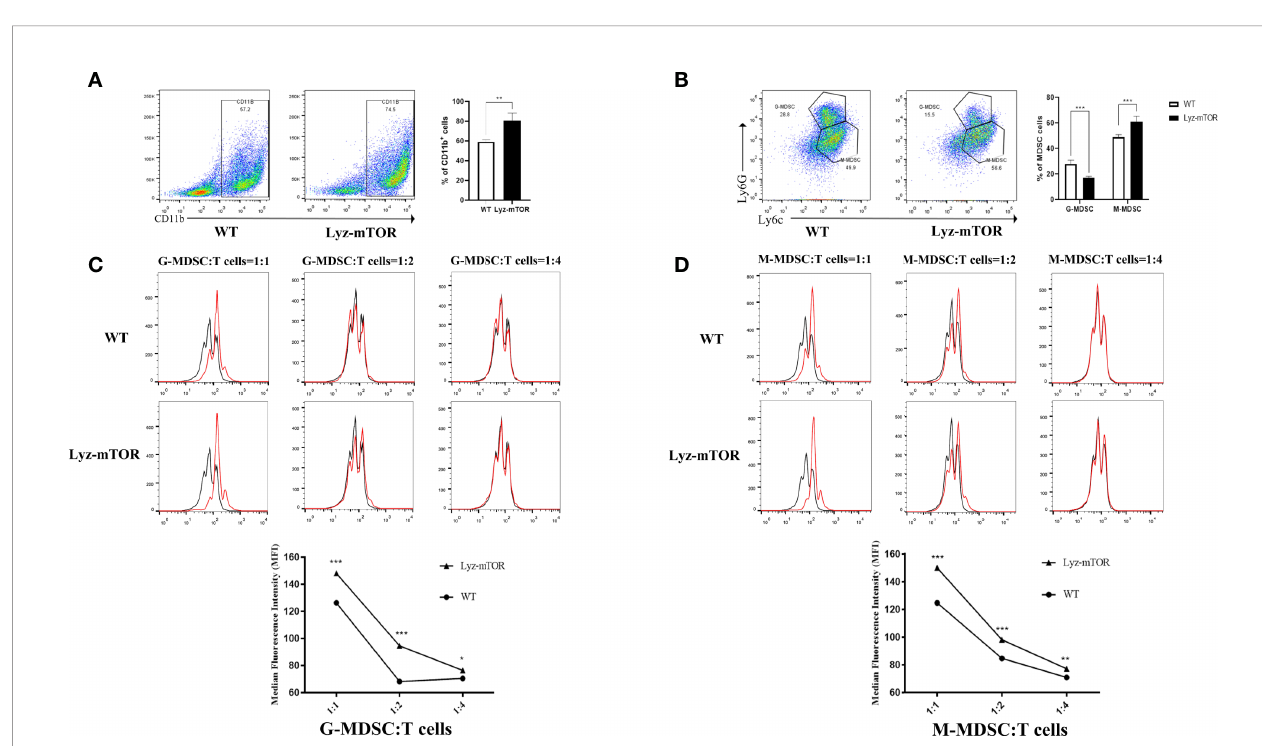
FIGURE 2 | Increased induced M-MDSC ratios and immunosuppressive functions in Lyz-mTOR mice. (A) Percentages of CD11b + cells from WT and Lyz-mTOR mouse BM. (B) Percentages of G-MDSCs and M-MDSCs from WT and Lyz-mTOR mice. (C, D) Induced G-MDSCs and M-MDSCs were co-cultured with T cells stimulated by ConA (G/M-MDSCs: T cells = 1:1, 1:2, and 1:4). CFSE-labeled T cell proliferation pattern was examined using fl ow cytometry analysis of CFSE dilution in gated CD4 + T cells. G/M-MDSCs inhibitory curves were generated (n = 5, *P < 0.05, **P < 0.01, and ***P <